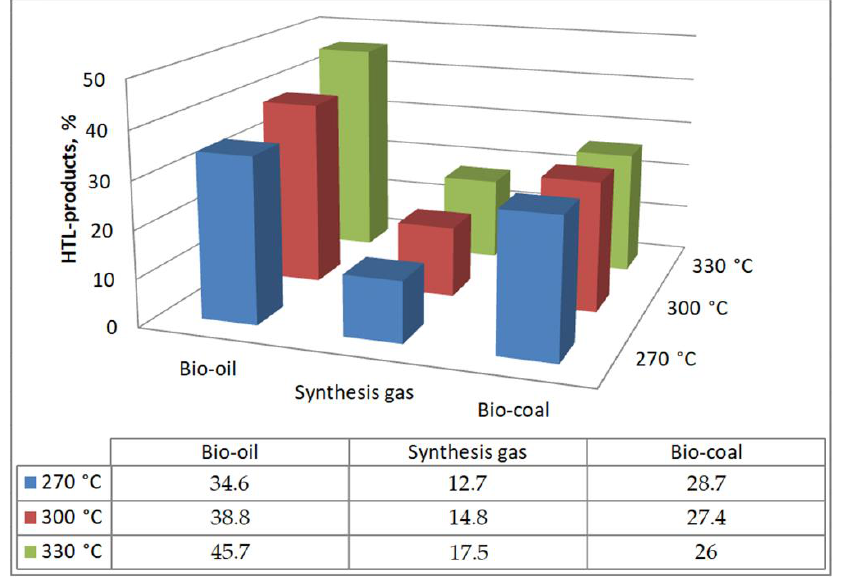
Figure 3. Products of biomass conversion by HTL of A. platensis at 270 °C, 300 °C and 330 °C.